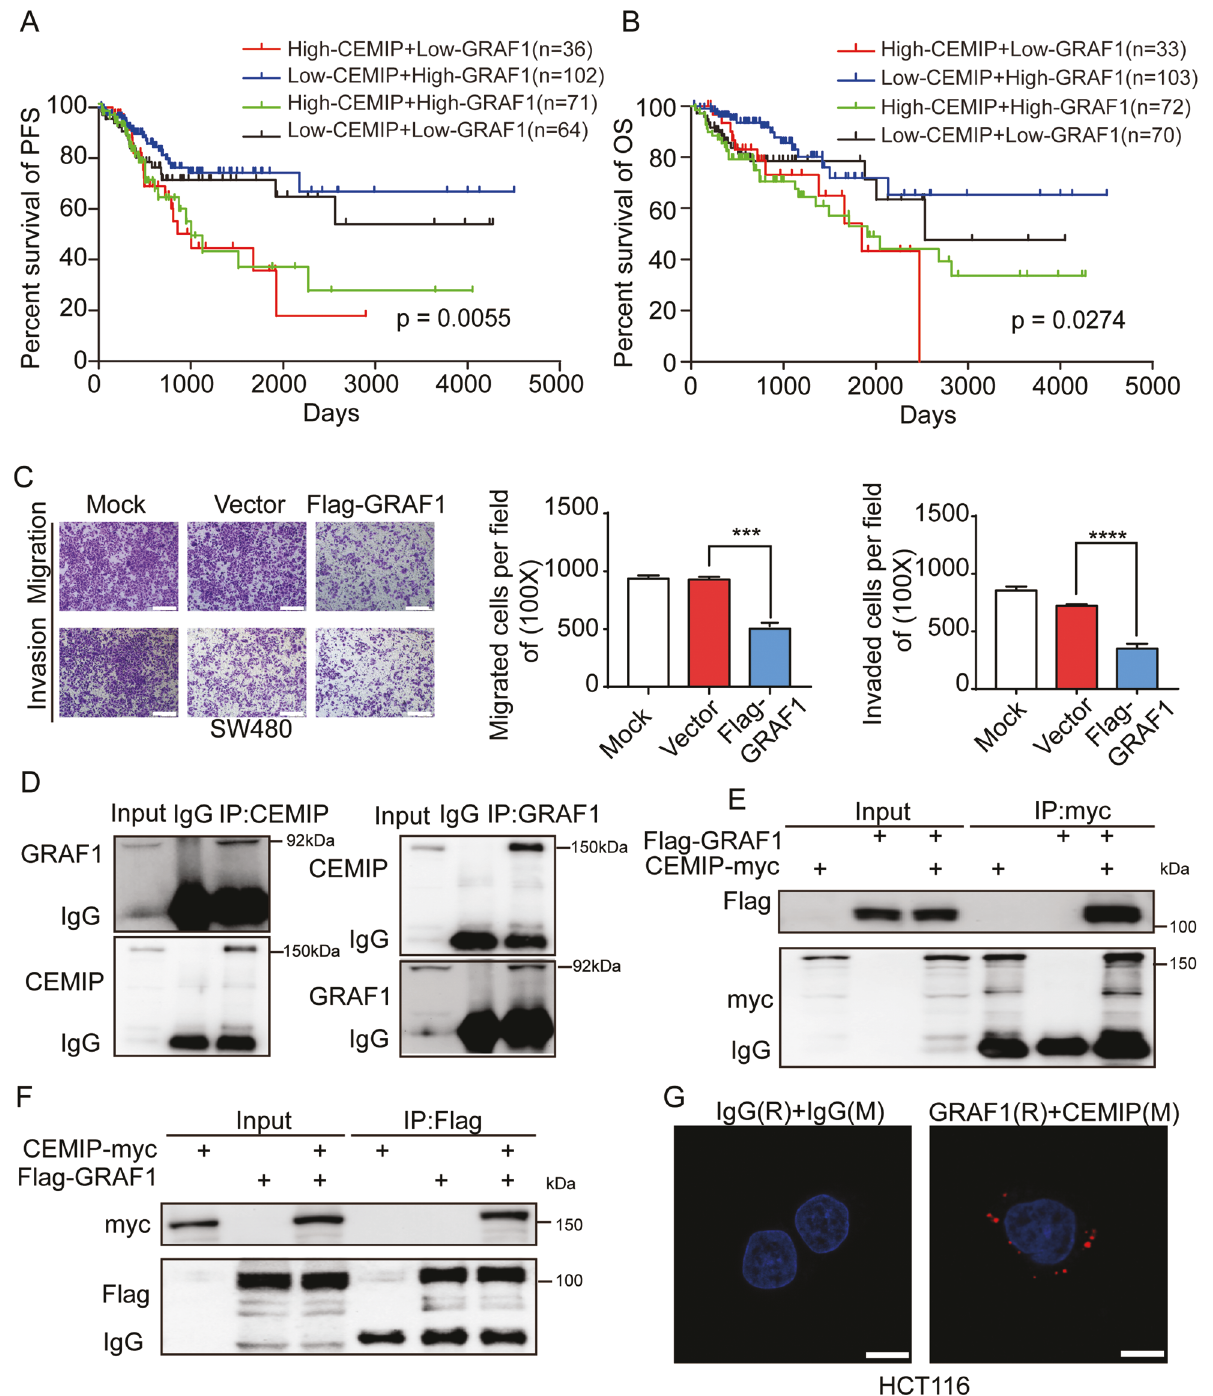
Fig. 1 CEMIP has negative correlation with GRAF1 in CRC. A , B The Progression Free survival (PFS, A ) and Overall Survival (OS, B ) of colon cancer patients were generated through TCGA (The Cancer Genome Atlas) database from http://www.sangerbox.com/. C Transwell chamber migration and invasion of SW480 cells transfected with Flag-GRAF1(GRAF1-overexpression plasmid with Flag tag attached in N terminal of GRAF1) or Scramble plasmid (negative control). *** P < 0.001; **** P < 0.0001. Scale bar, 50 μ m. D The interactions between endogenous CEMIP and endogenous GRAF1 were detected by Co-IP in HCT116 cells. E , F The interactions between exogenous CEMIP and exogenous GRAF1 were detected by Co-IP in HEK293T cells transfected with the indicated constructs. G The interaction between endogenous GRAF1 and CEMIP in HCT116 cells was further con fi rmed by the proximity ligation assays (PLA). Scale bar, 10 μ